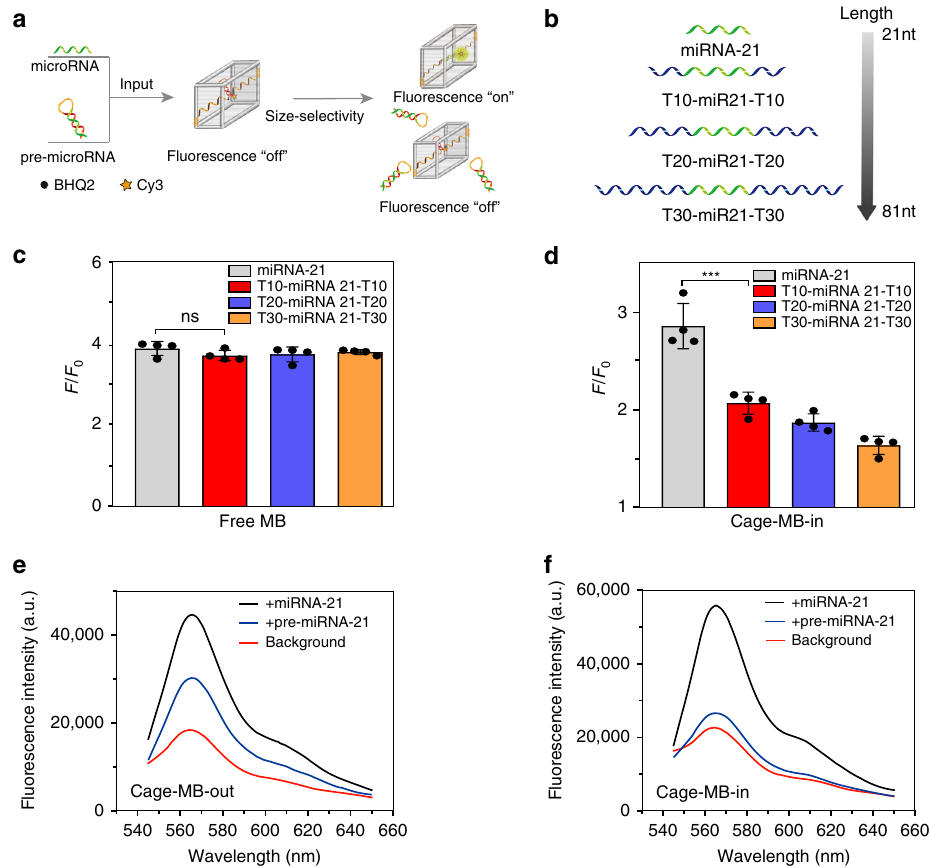
Fig. 6 Size-selective sensing of mature miRNAs. a Schematic illustration of size-selective molecular recognition to distinguish mature microRNA from precursor microRNA. b Schematic illustration of different lengths of nucleic acid targets containing the same recognition sequence of miRNA-21 . c , d Fluorescence response of free MB ( c ) and Cage-MB-in ( d ) to the nucleic acid targets with different lengths (F: fl uorescence intensity in the presence of target, F 0 : fl uorescence intensity in absence of target) ; Data are presented as mean values ± s.d. ( n = 4), ns = 0.17 (0.30, 0.37) for T10-miRNA 21-